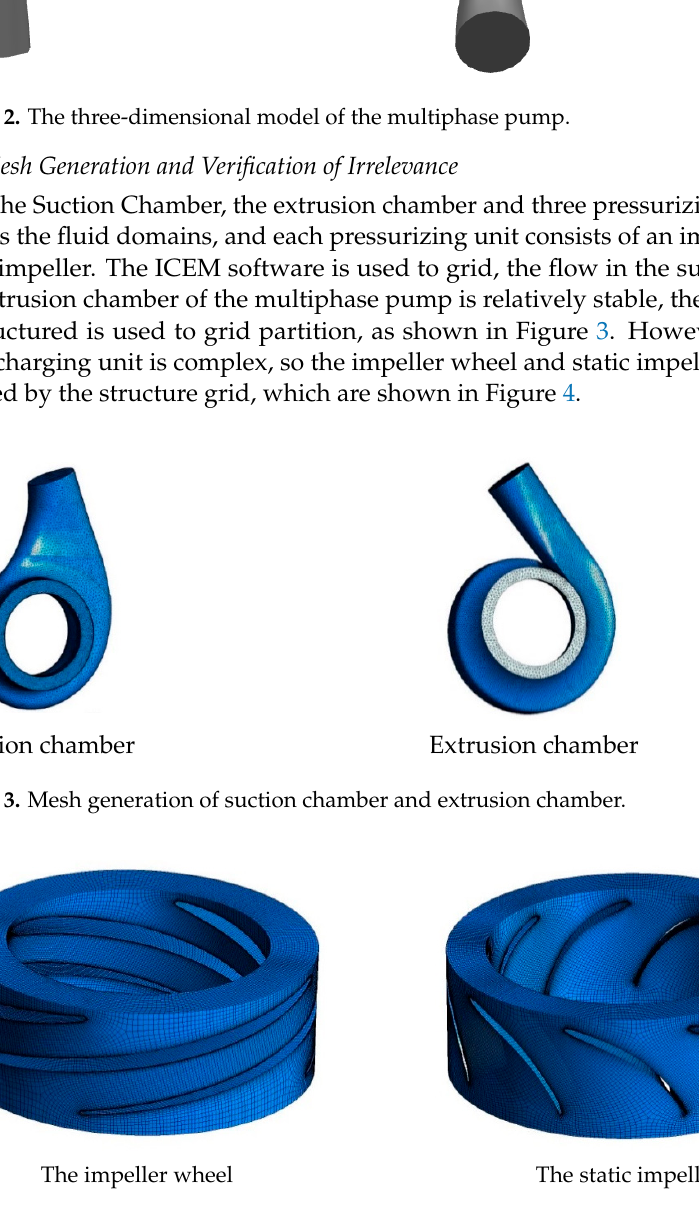
Figure 2. The three-dimensional model of the multiphase pump.